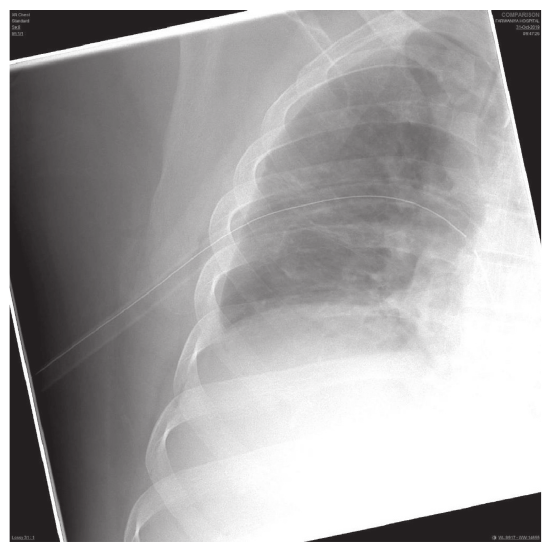
Figure 4: Intraoperative chest radiograph showing normal left lung field.